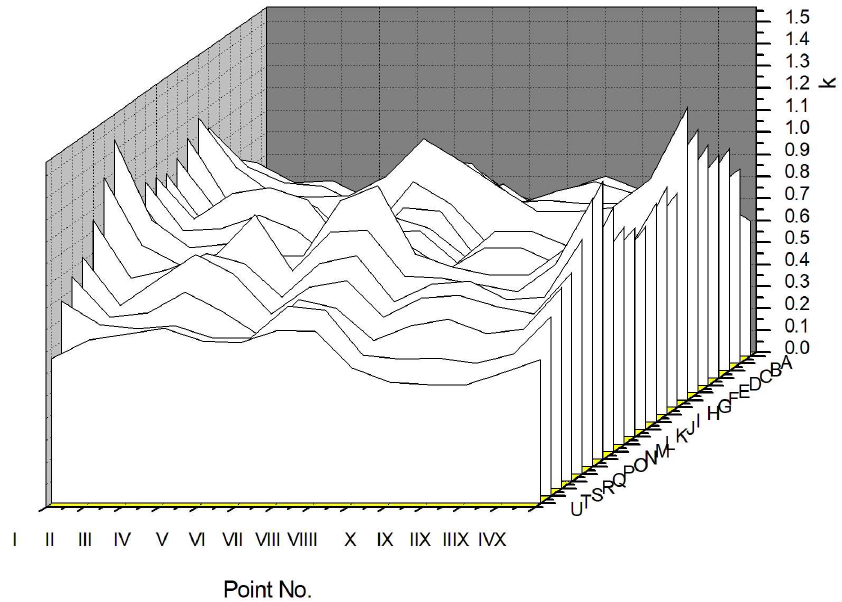
Figure 10. Profile of k in the dark field for green thin-film.